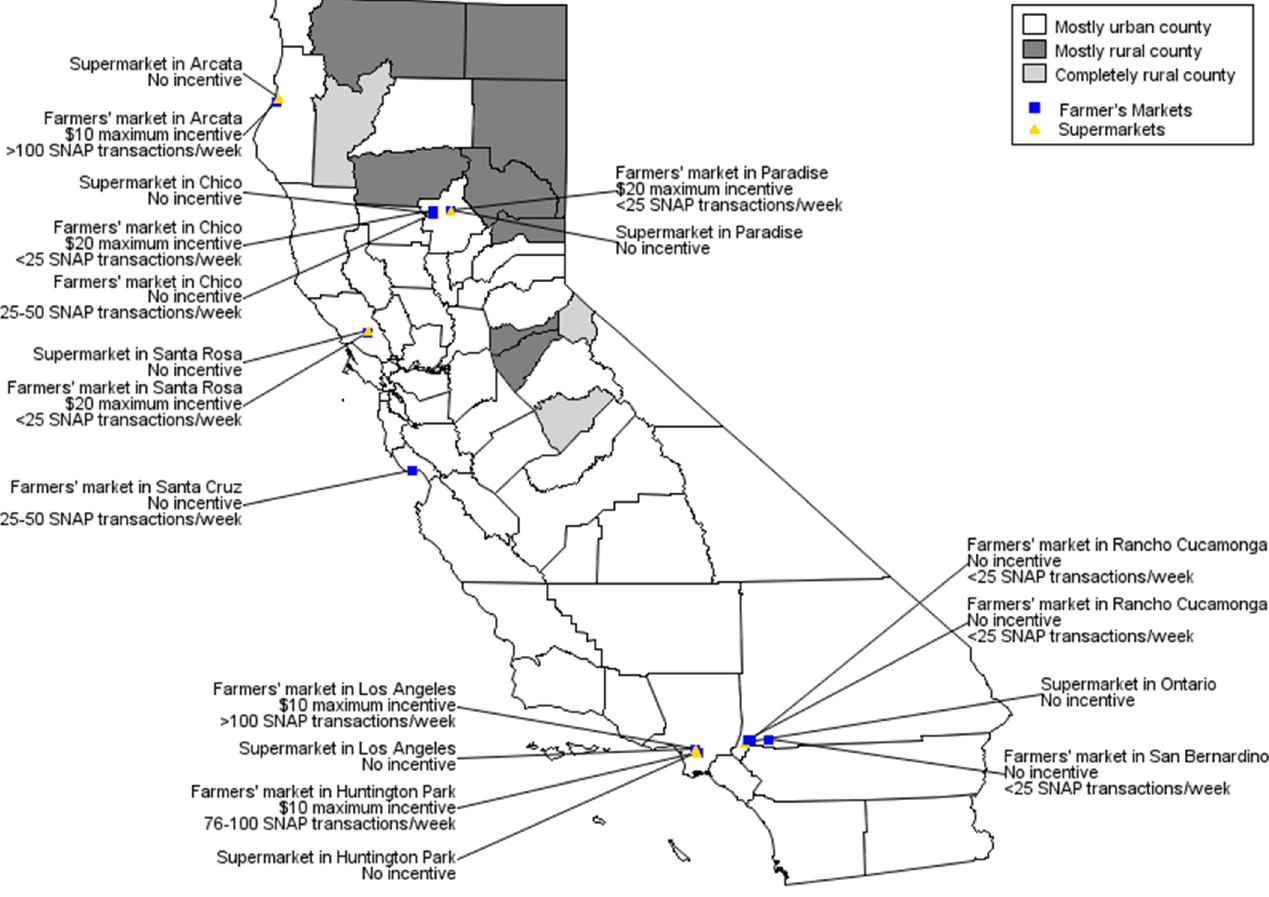
Figure 1. Location of farmers’ markets and supermarkets in sample, CNIP Evaluation, CA, 2018 ( n = 11 farmers’ markets, 7 supermarkets).